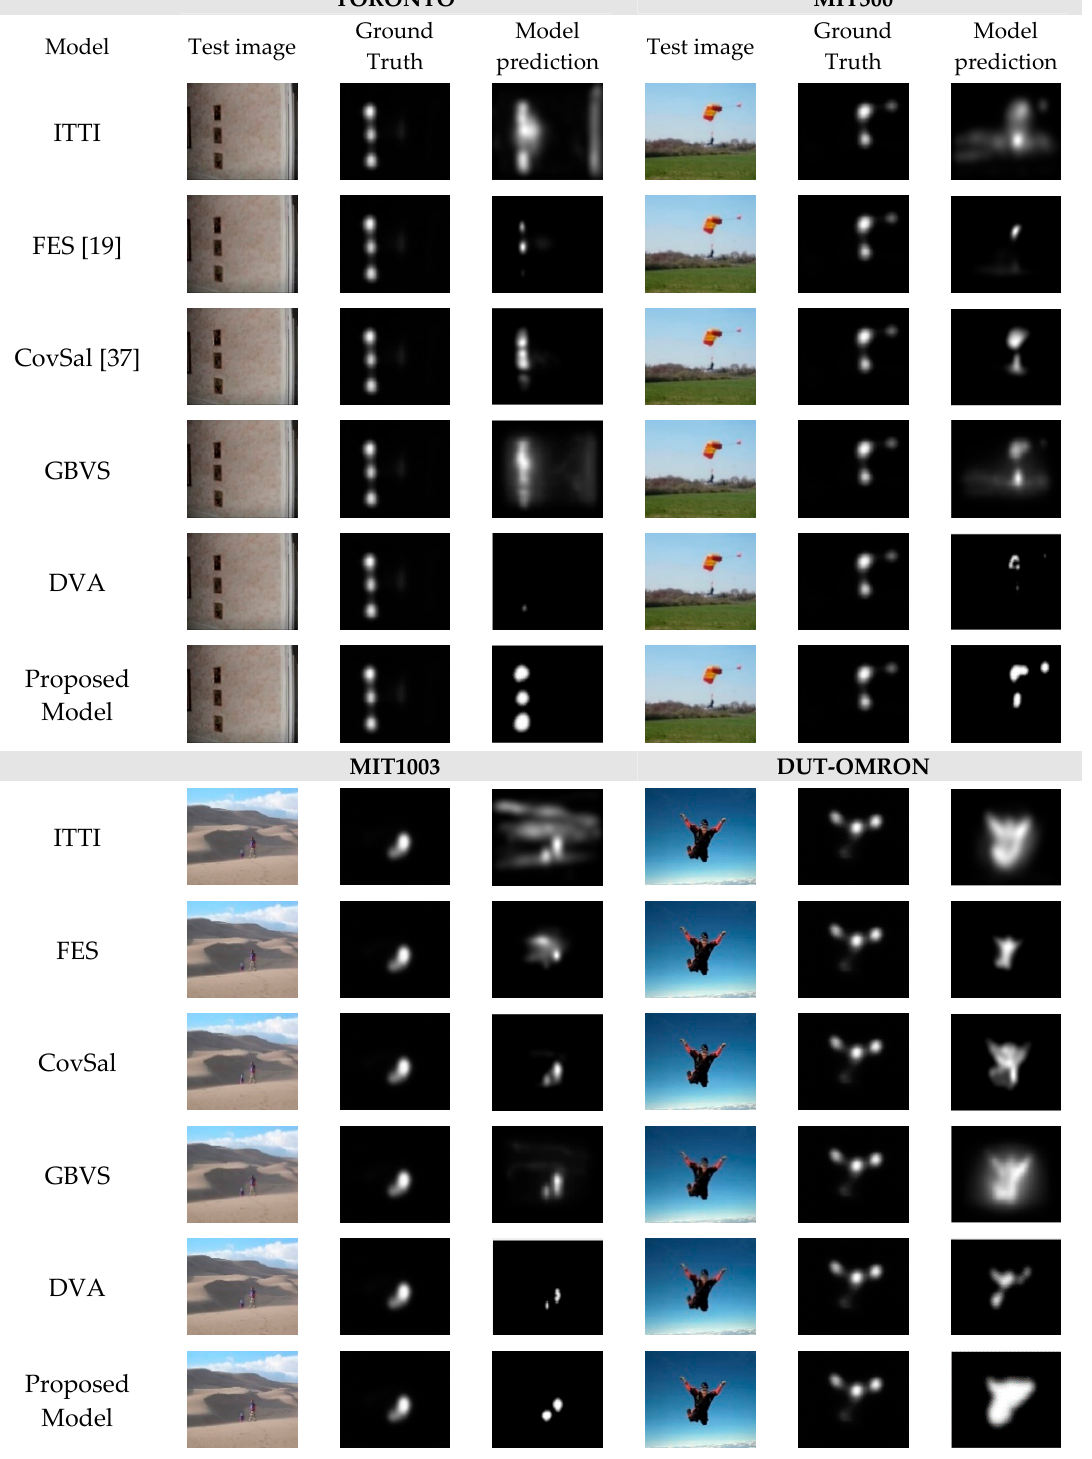
Figure 5. The saliency maps obtained from the proposed model and five other state-of-the-art models for a sample image from the TORONTO, MIT300, MIT1003, and DUT-OMRON datasets.